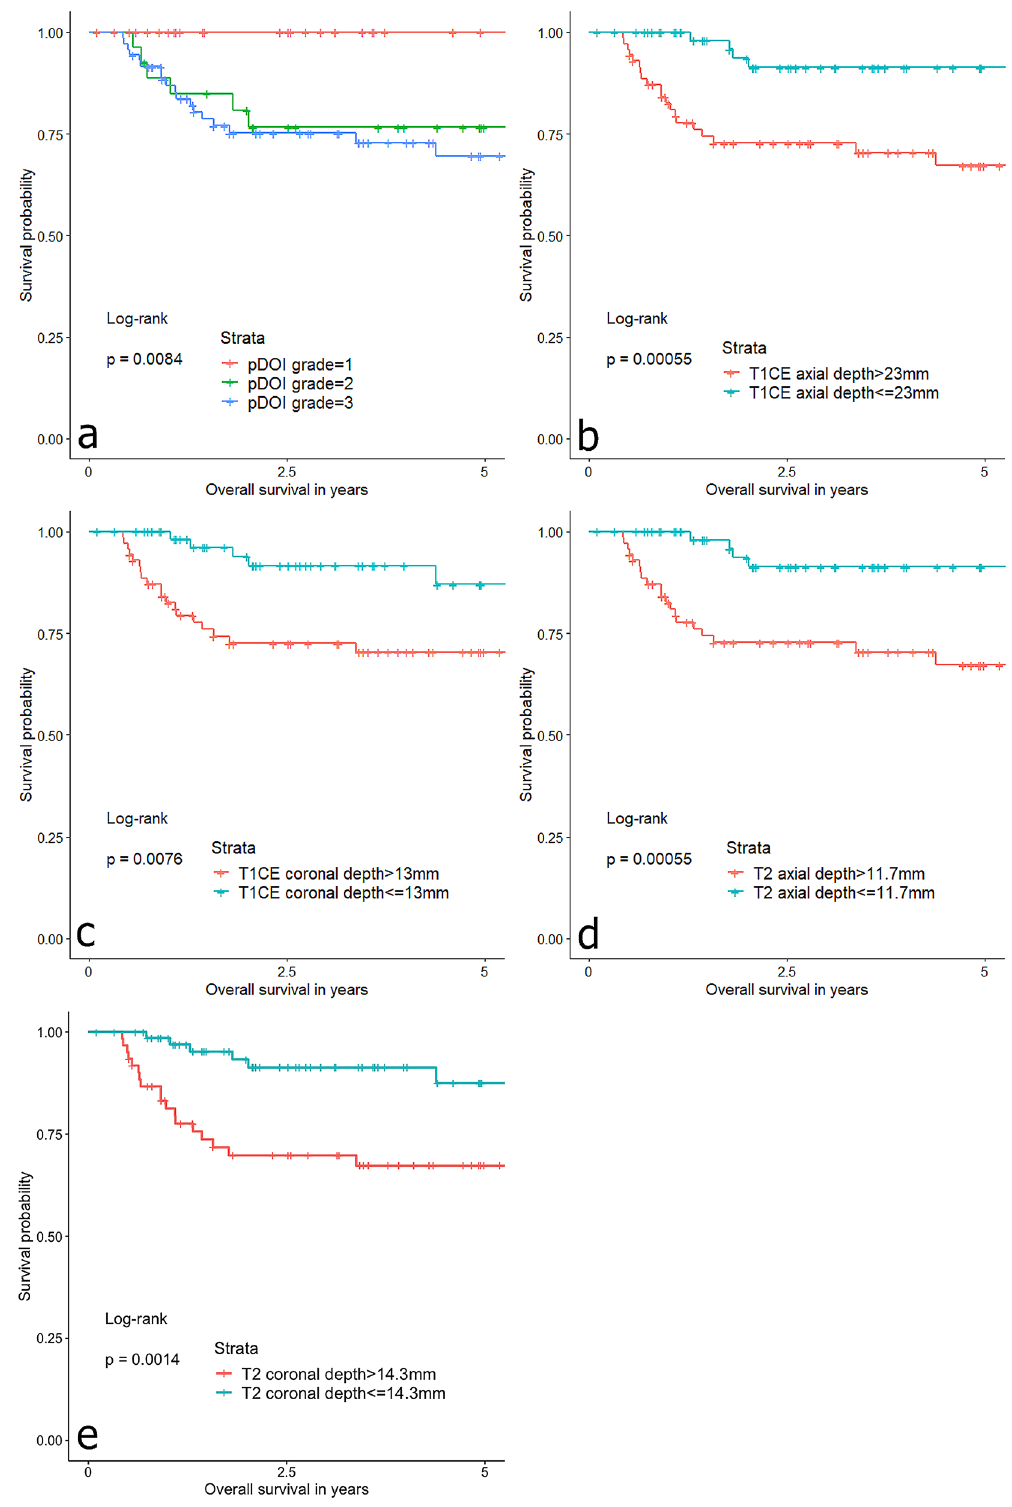
Figure 5. Kaplan–Meier curves for overall survivals based on ( a ) pathologic depth of invasion (pDOI) grades, ( b ) axial CE-T1WI, ( c ) coronal CE-T1WI, ( d ) axial T2WI, and ( e ) coronal T2WI, stratified by the thicknesses